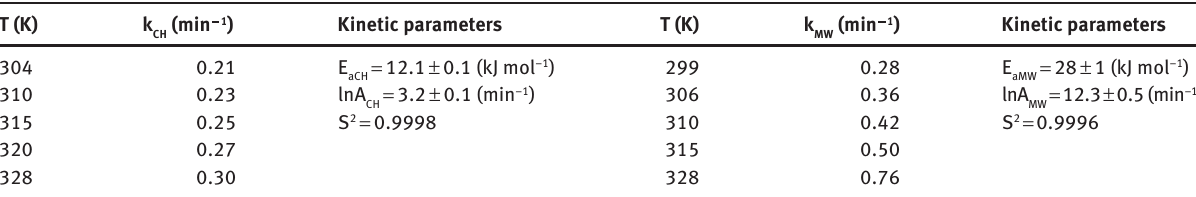
Table 3: Calculated values of the rate constants and apparent kinetic parameters of the alkali-catalyzed TSMPC under the CH and MWHCC conditions.